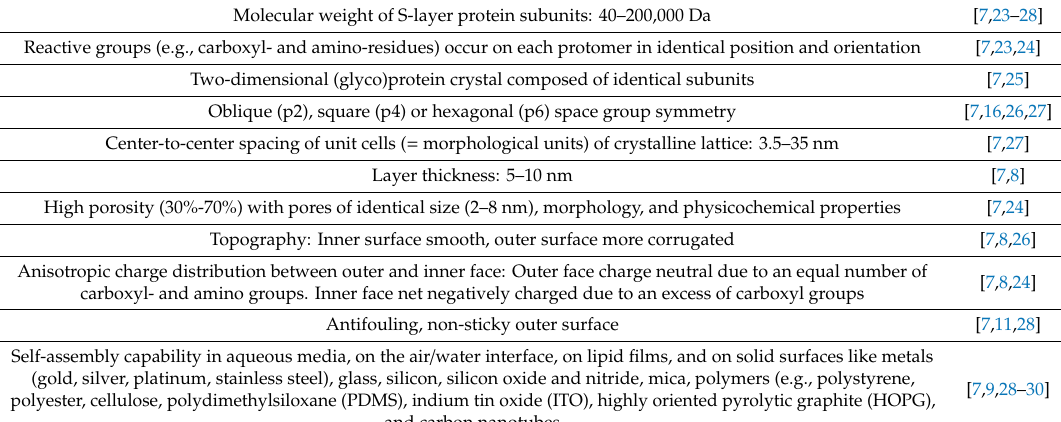
Table 1. Summary of the biosensor-relevant properties of S-layer proteins and lattices Reference. Molecular weight of S-layer protein subunits: 40–200,000 Da [7,23–28] Reactive groups (e.g., carboxyl- and amino-residues) occur on each protomer in identical position and orientation Two-dimensional (glyco)protein crystal composed of identical